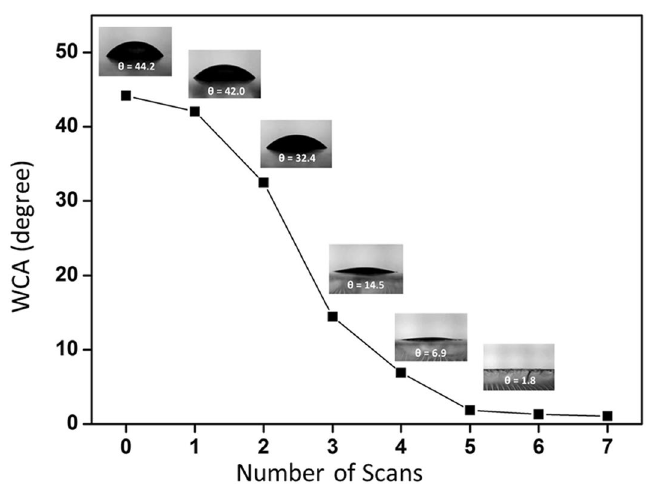
Figure 8. Variation of water contact angle with number of